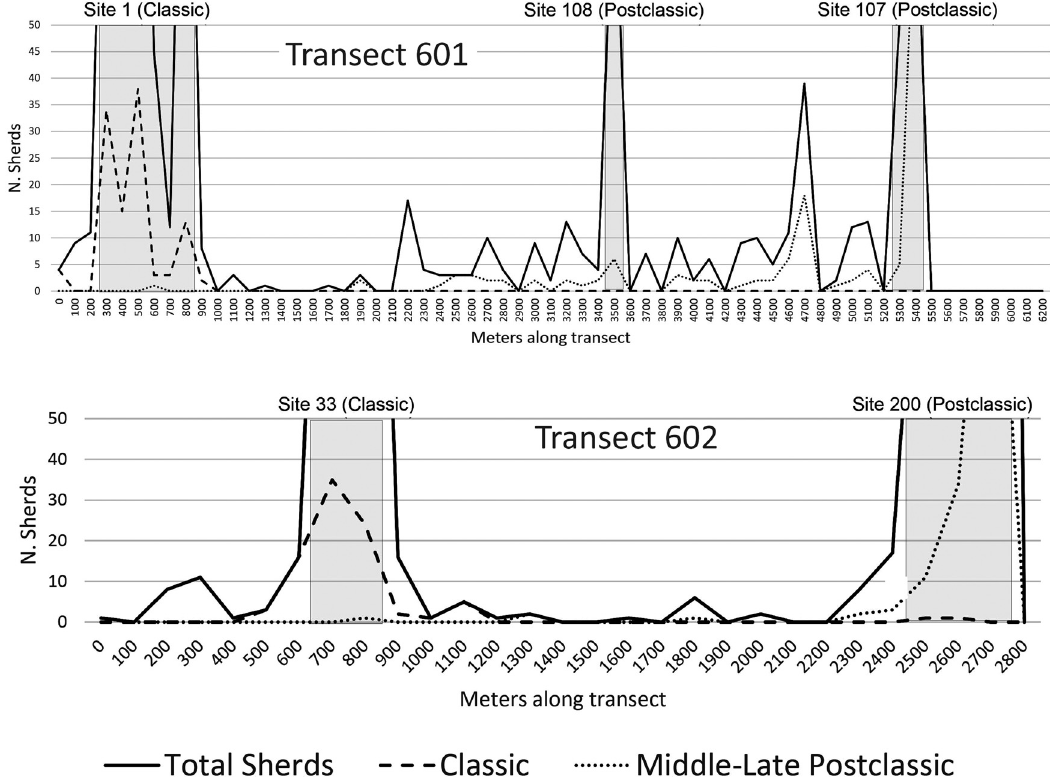
Figure 22: Sherd counts per collection along two systematic transects ( nos. 601 and 602 ) . For each collection, the total sherd count, number of Classic - period diagnostic sherds, and the number of Middle - Late Postclassic diagnostic sherds are shown. On - site collections are indicated by shading. The y - axis is capped at 50 sherds to emphasize the smaller o ff - site collection; many on - site collections have more than 50